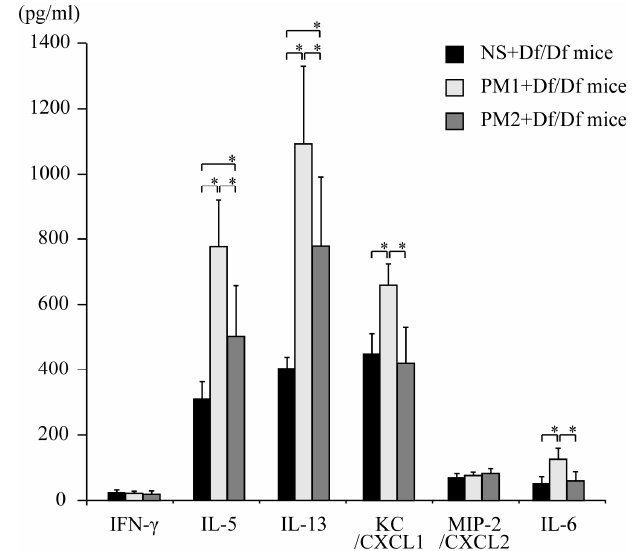
Figure 2. Cytokine and chemokine levels in bronchoalveolar lavage fluid (BALF). The BALF cytokine and chemokine expression profiles were analyzed using enzyme immunoassays for interferon- γ , interleukin-5, interleukin-13, keratinocyte-derived chemokine, macrophage inflammatory protein-2, and interleukin-6. Data for each group are expressed as mean ± standard deviation, and the results are from six mice per group. * p < 0.05.